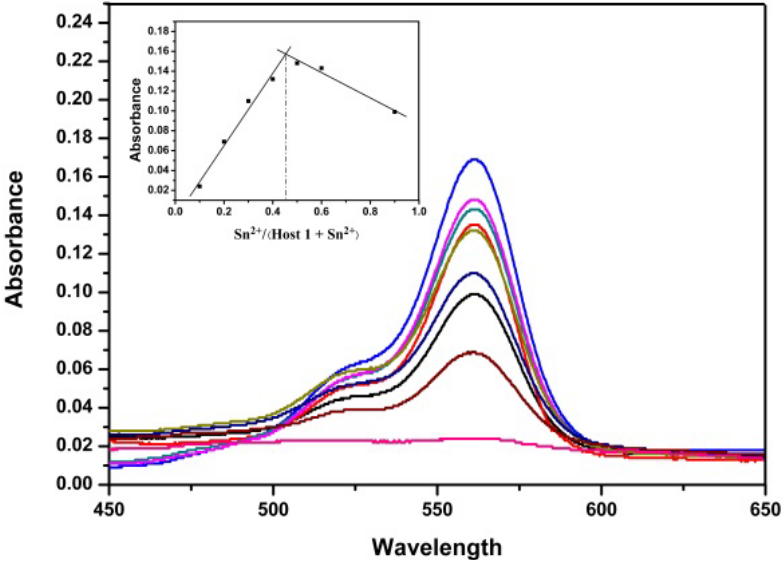
Figure 7. Job’s plot of RBAP in a MeOH/H concentration of [ RBAP ] + Sn 2+ = 100 μ M and a detection wavelength of 561